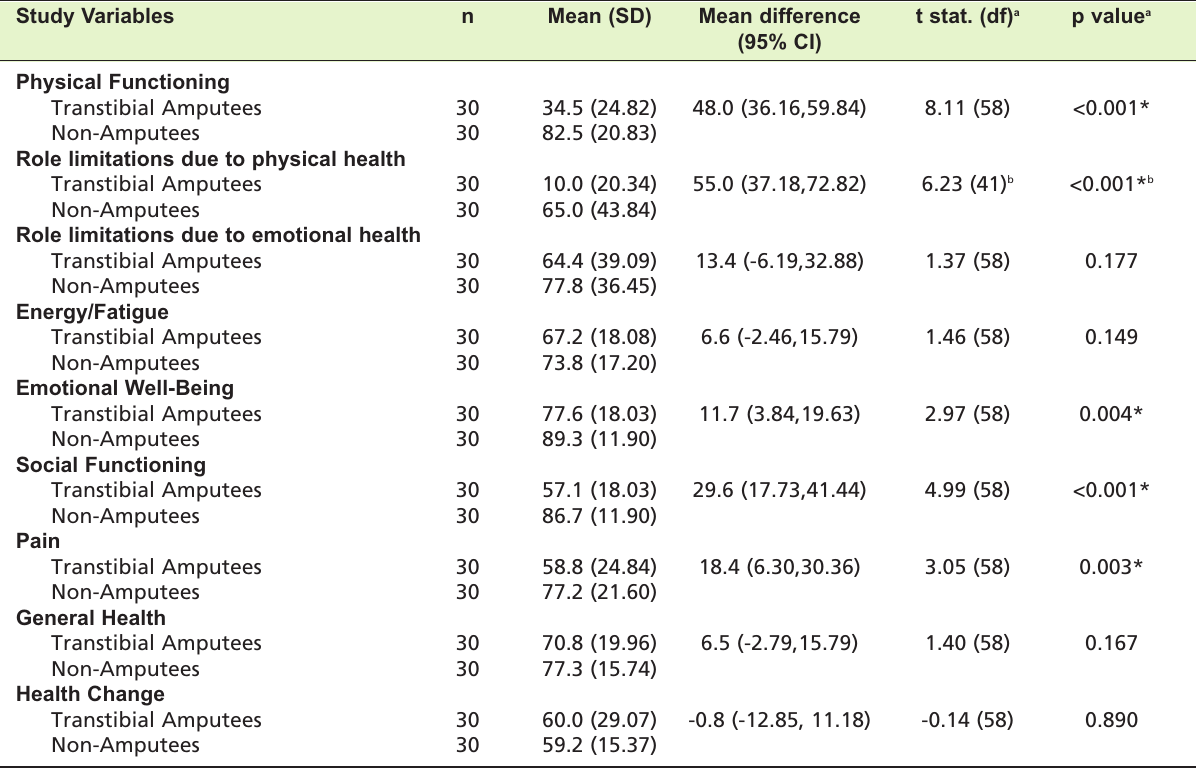
Comparison in QoL scores (SF-36) between TTA and Diabetic Non-TTA Table II: